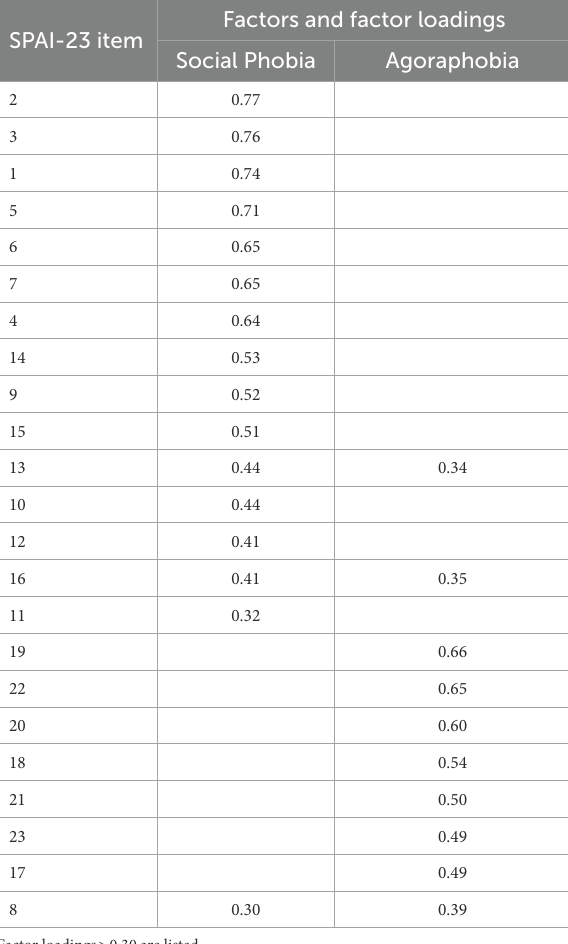
TABLE 3 Results of a three factor solution from a forced EFA using PAF and oblique